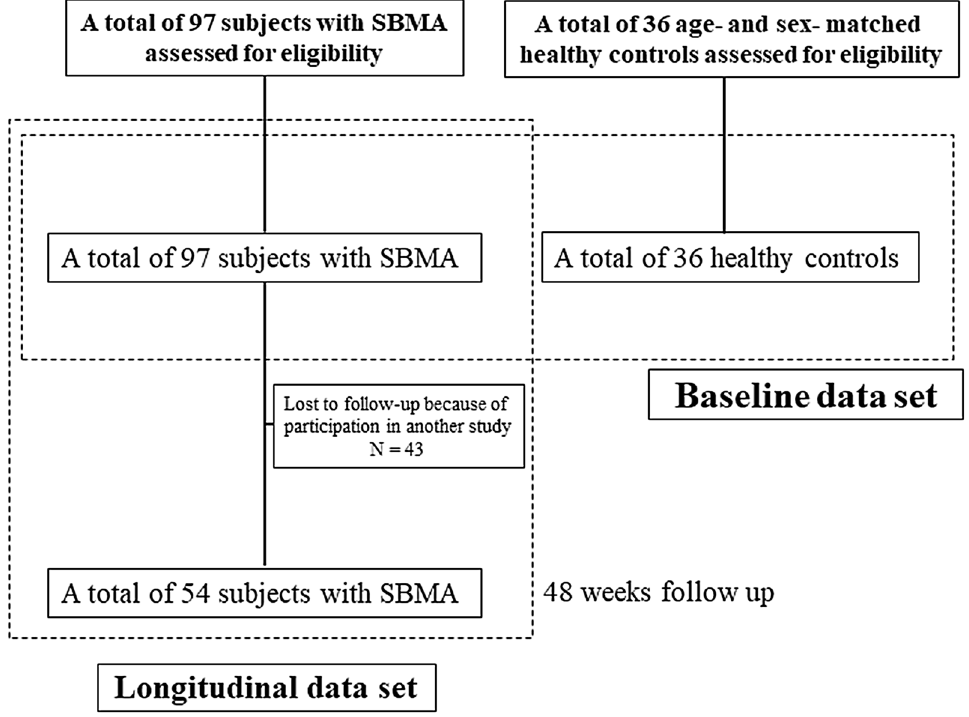
Figure 1. Flowchart of study population enrollment A total of 97 subjects with SBMA and 36 age- and sex- matched healthy controls with no diagnosed neurological disorders were enrolled. A total of 54 patients were followed up for 48 weeks. A total of 43 subjects at 48 weeks follow-up were lost because they participated in the other interventional clinical